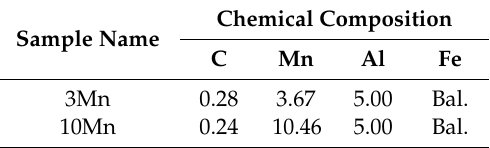
Table 1. Chemical composition of the experimental steels